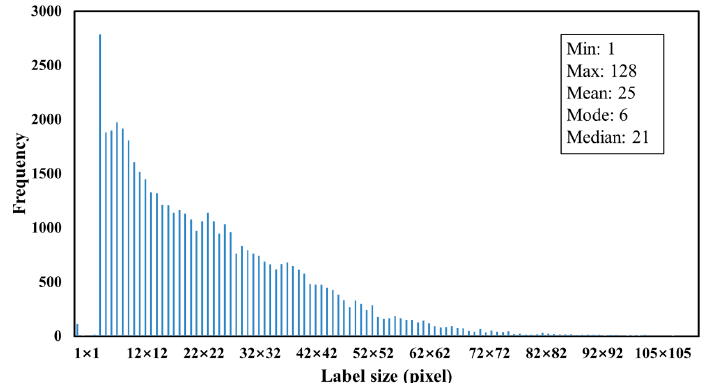
Figure 8. Frequency diagram and descriptive statistics of purple leaf size in unmanned aerial vehicle (UAV) imagery with resolution of 1.86 mm/pixel.